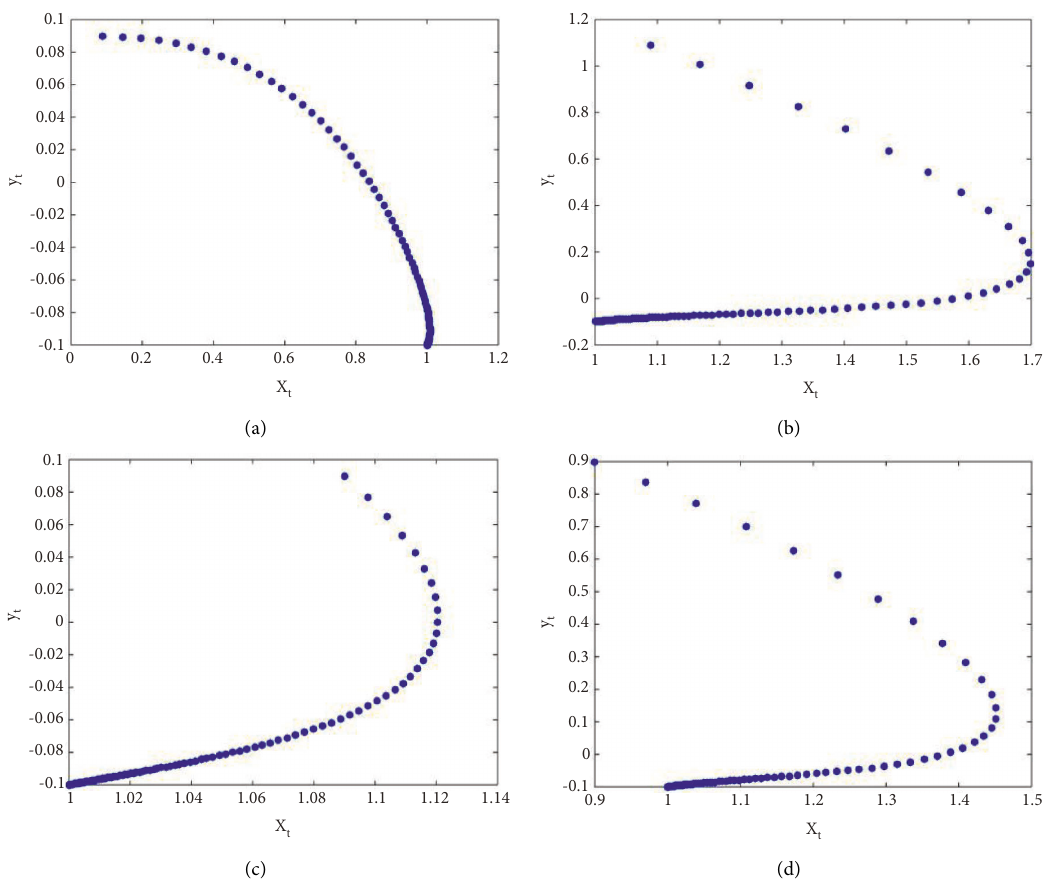
Figure 6: A stable node of the Brusselator system (10). (a) h � 0.06 with (0.09, 0.09), (b) h � 0.06 with (1.09, 1.09), (c) h � 0.06 with (1.09, 0.09), and (d) h � 0.076 with (0.9, 0.9).